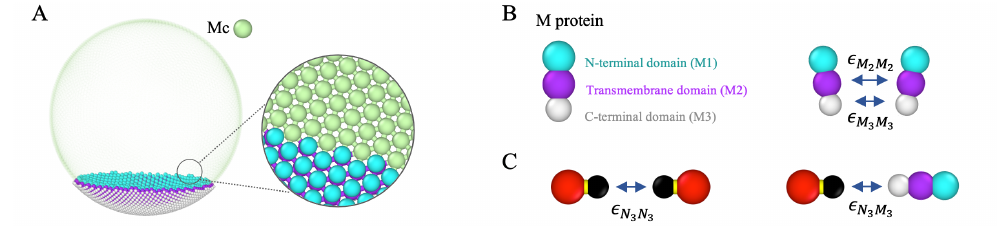
Figure 3. ( A ) A schematic view of ERGIC. The membrane vertices (Mc) are green and the M protein particles are colored blue-purple-white. The right figure shows the bond connections in the ERGIC membrane built from a triangular lattice. ( B ) a schematic view of an M protein. The coarse-grained M protein model contains three hard particles: M1 (N-terminal domain, blue); M2 (Transmembrane domain, purple), and M3 (C-terminal or cytosolic domain, white). The arrows indicate the attractive M2–M2 and M3–M3 interactions. The diameters of M1 and M2 are equal while that of M3 is smaller than the other two, which is the source of the intrinsic curvature of M proteins; ( C ) illustration of the N–N (left) and N–M (right) interactions. The attractive interactions between domains are indicated with arrows, where the C-terminal of the N proteins (N3) attracts each other, and N3 also attracts the C-terminal of M proteins